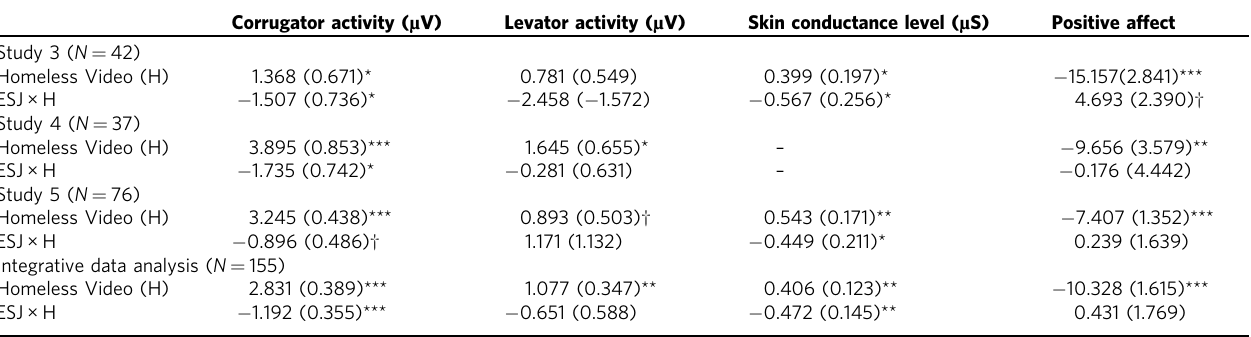
Table 6 Psychophysiological responses as a function of economic system justi fi cation (ESJ) and video type in Studies 3 – 5 and